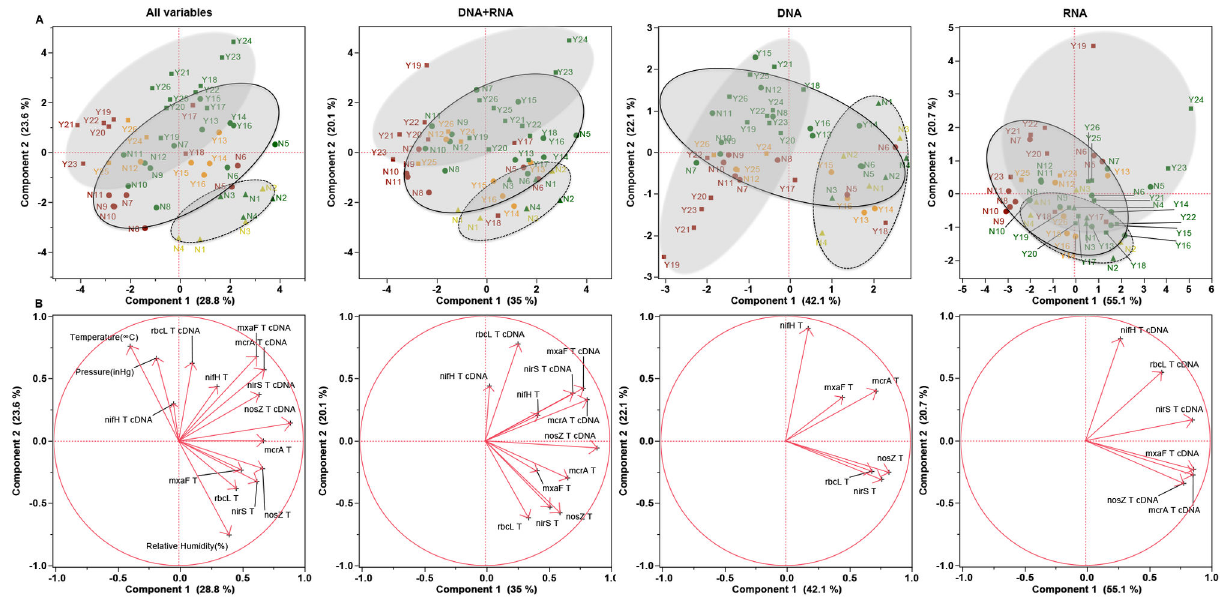
Figure 2. Principal component analysis (A) and factor loadings (B) for (from right to left) transcript (mRNA) abundances, gene abundances, gene and transcript abundance combined, and gene and transcript abundances combined with atmospheric data. Samples are labeled sequentially by treatment (green=background site; red=treatment site active CO injection; 2 orange=treatment site post-CO injection; and yellow=treatment site pre-CO injection), and by month (N=June, Y=July-Sept). 2 2 Shaded areas represent pre-injection period (N1 - 4, ▲), June injection period (N5 - 12 and Y1 3- 16, ●) and July injection period (Y17 - 26, ■). The percentage of the variation in the samples described by the plotted principle components is indicated on the axis. Gene names in Panel B are as for Figure